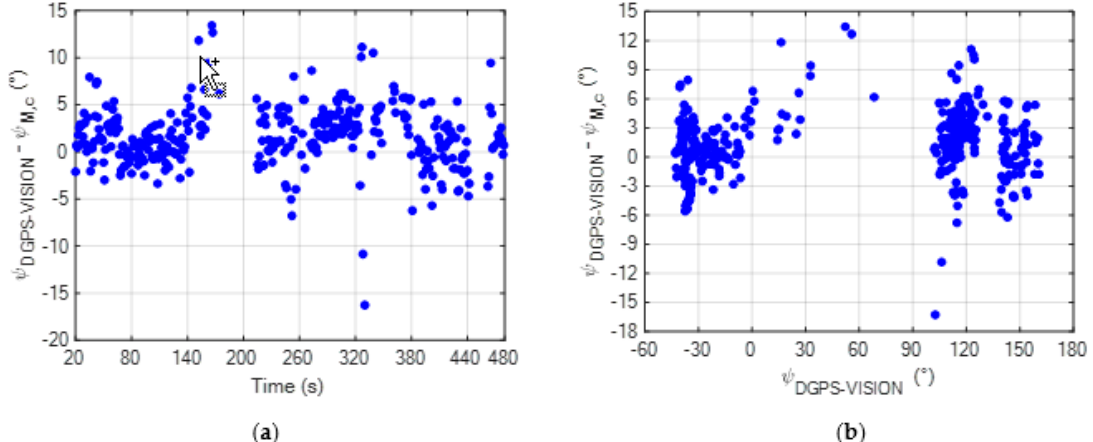
Figure 8. ( a ) Time variation of ψ ERR for the calibrated magnetic heading ( ψ M,c ) during the flight test; ( b ) Variation of ψ ERR for the calibrated magnetic heading ( ψ M,c ) as a function of the reference heading solution obtained using the DGPS-vision algorithm [11].